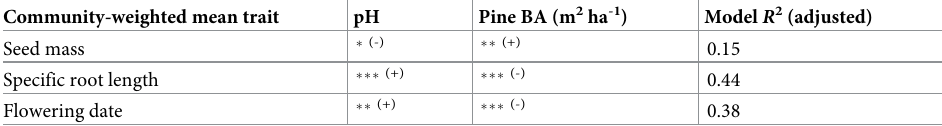
Cubic-spline regression smoothers (Generalized Additive Models) were used to fit the models using the